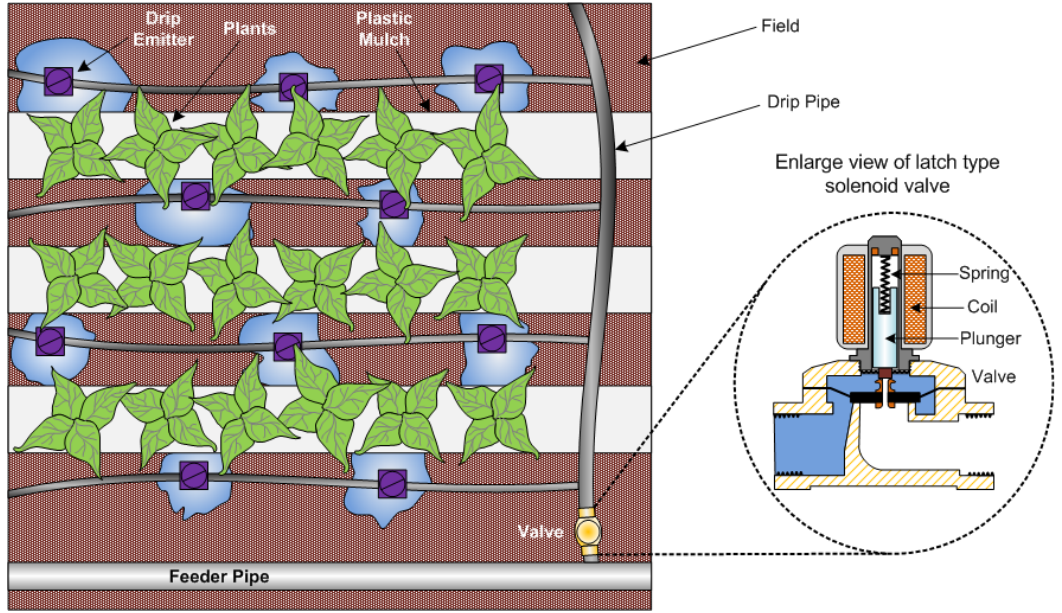
Figure 12. Localized irrigation system and latch-type Solenoids